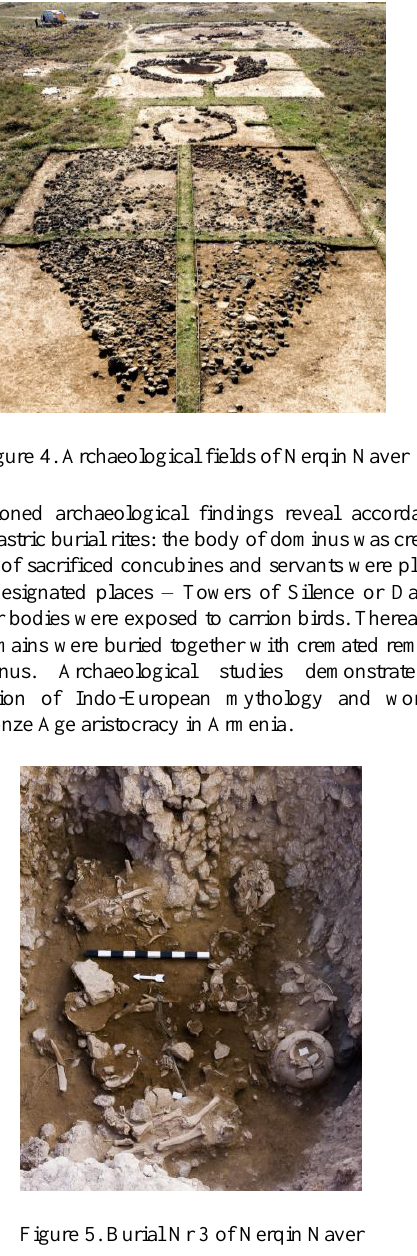
Figure 3. Automatically set landmarks on a tooth section